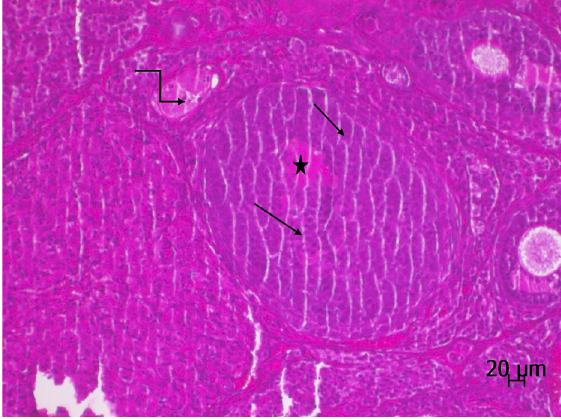
Figure 7. A section of ovarian tissue of the OIRM group showing cystic change (asterisks) with a small amount of fluid accumulation in the lumen and a small number of follicular cells, (arrow), mild congestion (zigzag arrow), (H&E).